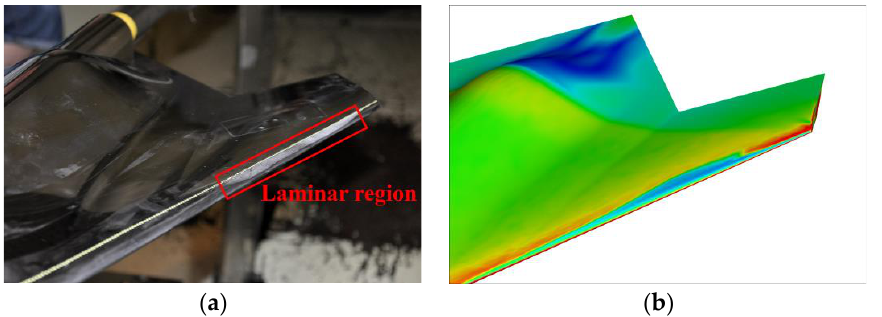
Figure 5. Comparison of experimental data and simulation results ( T u = 0.7%, M = 0.9, α = 2°). ( a ) Wind tunnel test transition result; ( b ) simulated transition result. The contour shows the friction coefficient distribution.